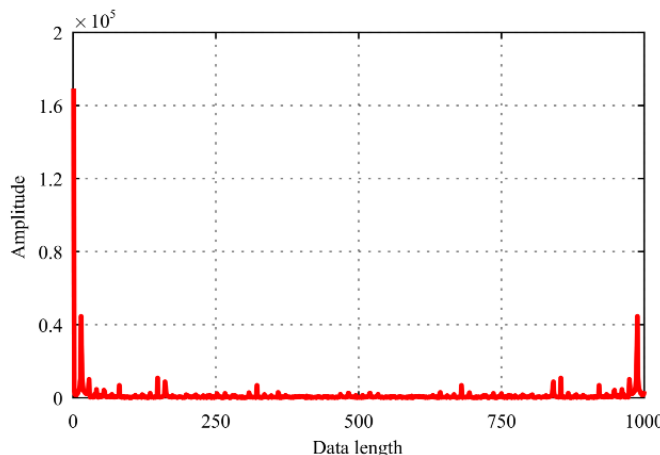
Figure 5. Waveform of transformed